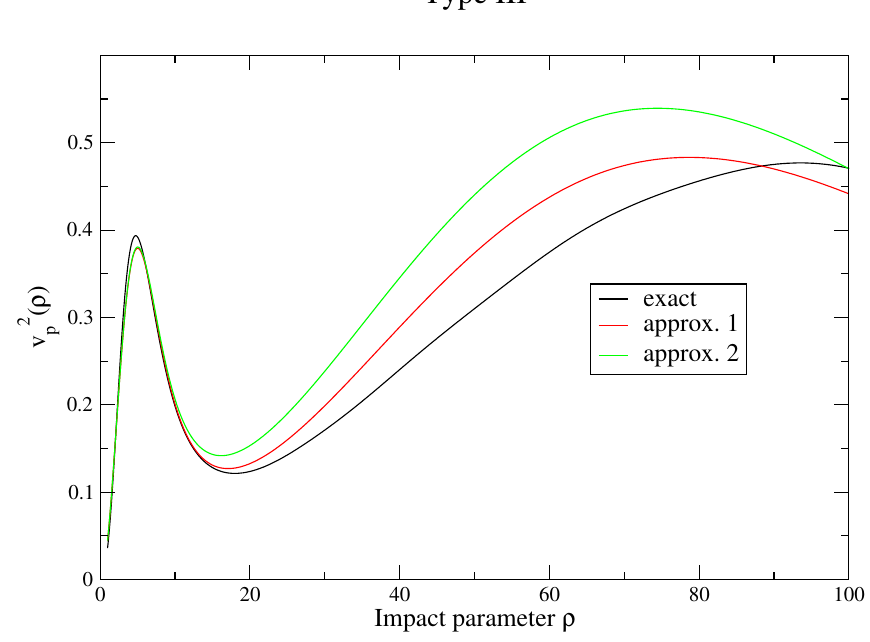
Figure 10. Comparison between the exact computation of v 2 p ( ρ ) and the approximate expressions v p,app (see Equation (63)) and v p,app,2 (see Equation (68)) for n α = 8, (cid:96) α = 1, m α = 1, (cid:96) α (cid:48) = 1, and m α (cid:48) = 1, n β = 2, (cid:96) β = 0, m β = 0, (cid:96) β (cid:48) = 0, and m β (cid:48) = 0 (Type